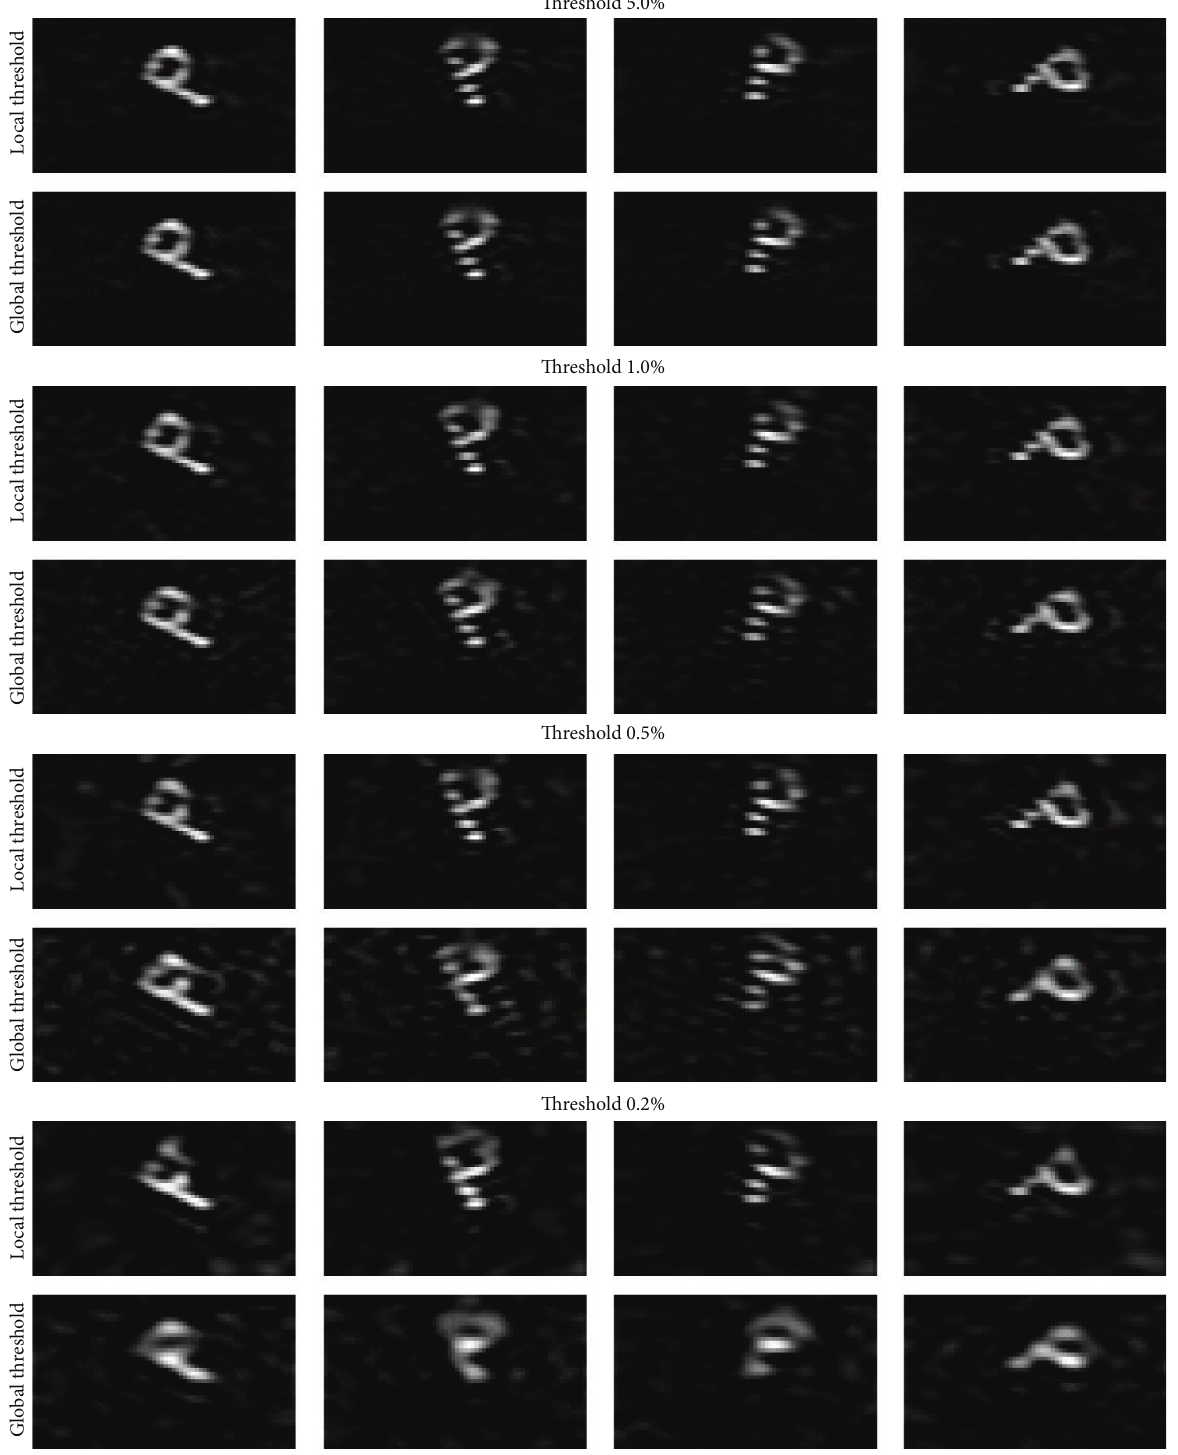
Figure 2: Reconstructed MPI data at four selected time points using the sparse reconstruction algorithm with a DCT basis transformation using a local and a global threshold for matrix compression. The compression rates are between 0.2% and